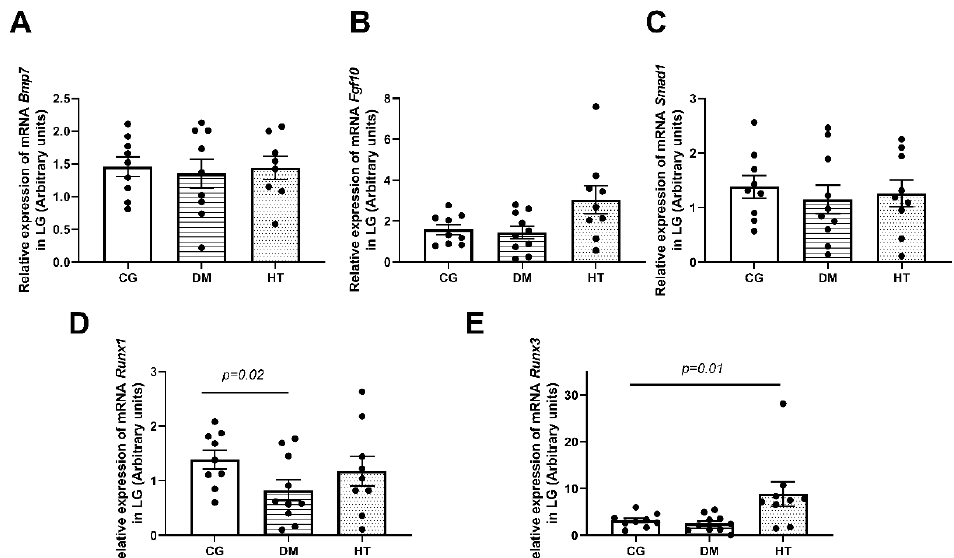
Figure 3. Relative mRNA expression of pro-mitotic elements in the LG of the DM, HT, and control groups at their final experimental period ( A – E ). The results show a lower expression of Runx1 mRNA in DM group ( p = 0.02) ( D ), and a higher expression of Runx3 in HT group ( p = 0.01) compared to the CG ( E ). No changes were observed in other pro-mitotic elements ( A – C ). The n = 10/group and the comparisons between DM or HT groups and the CG were made using the Mann–Whitney U test. Each animal value is represented by a black dot in the figure. In the TG, among the four cytokines tested, Il6 mRNA was higher in the DM group, and Il1b mRNA was higher in the HT group ( n = 10/group; p = 0.02 and p = 0.004, respectively) (Figure 4).